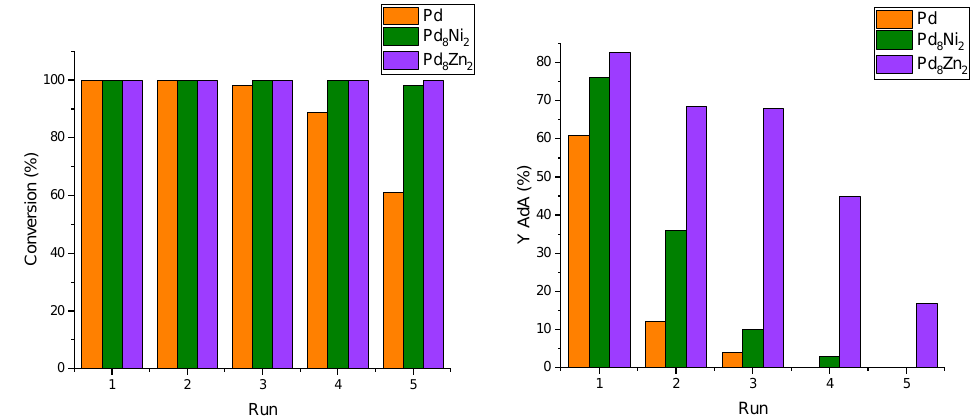
Figure 4. MA conversion (left) and yield of AdA (right) after 120 min during recycling tests.